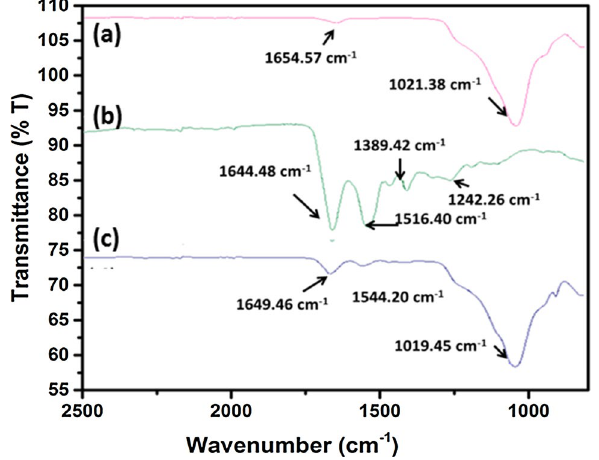
Fig. 5 FTIR spectra of DC ( a ), BSA ( b ) and BSA adsorbed DC ( c ) after 120